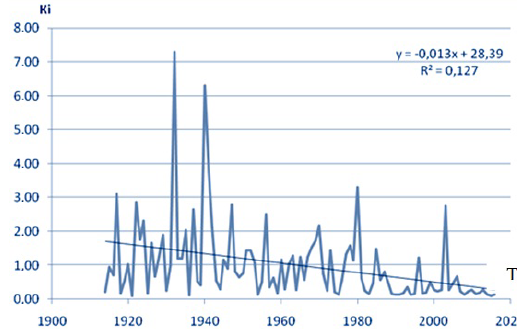
Figure 7. The time series of maximal water discharges of spring floods on the river Southern Bug – village Oleksandrivka, A = 46200km 2